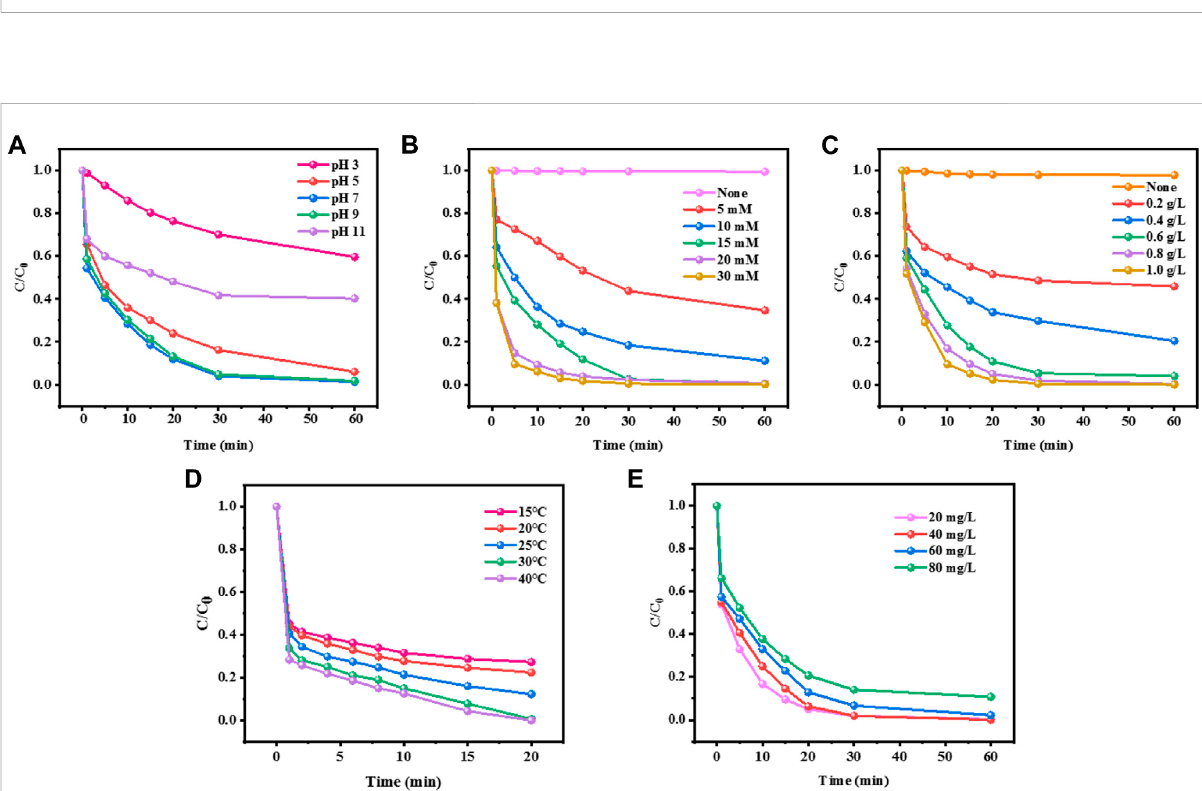
FIGURE 7 Effect of (A) initial pH, (B) H 2 O 2 dosage, (C) catalyst dosage, (D) reaction temperature, and (E) initial MO concentration on the removal of